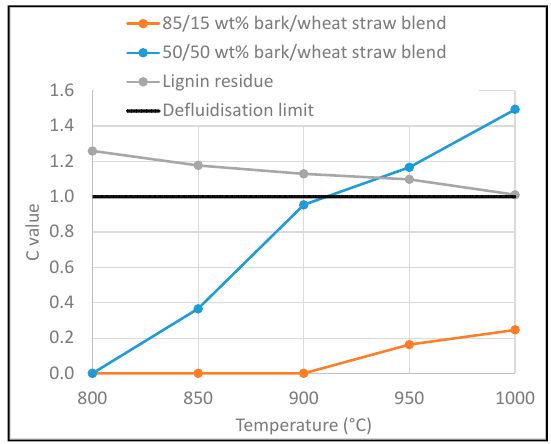
Figure 11. C criteria value as a function of temperature in air oxidation conditions.